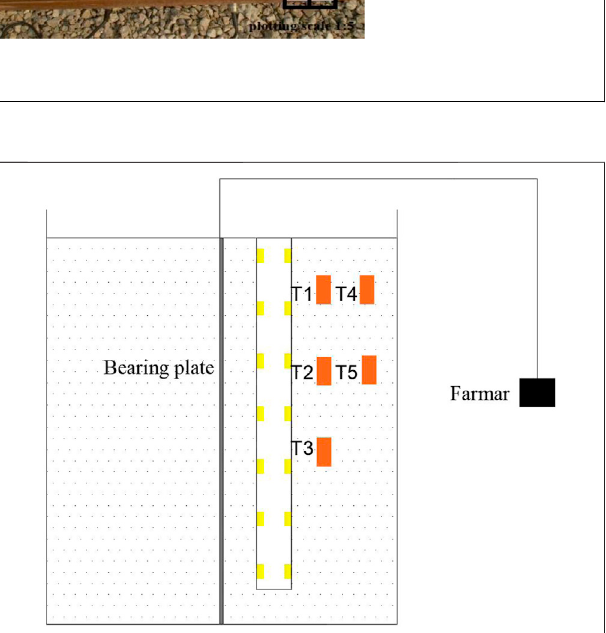
FIGURE 5 | Layout of the indoor model test under wave